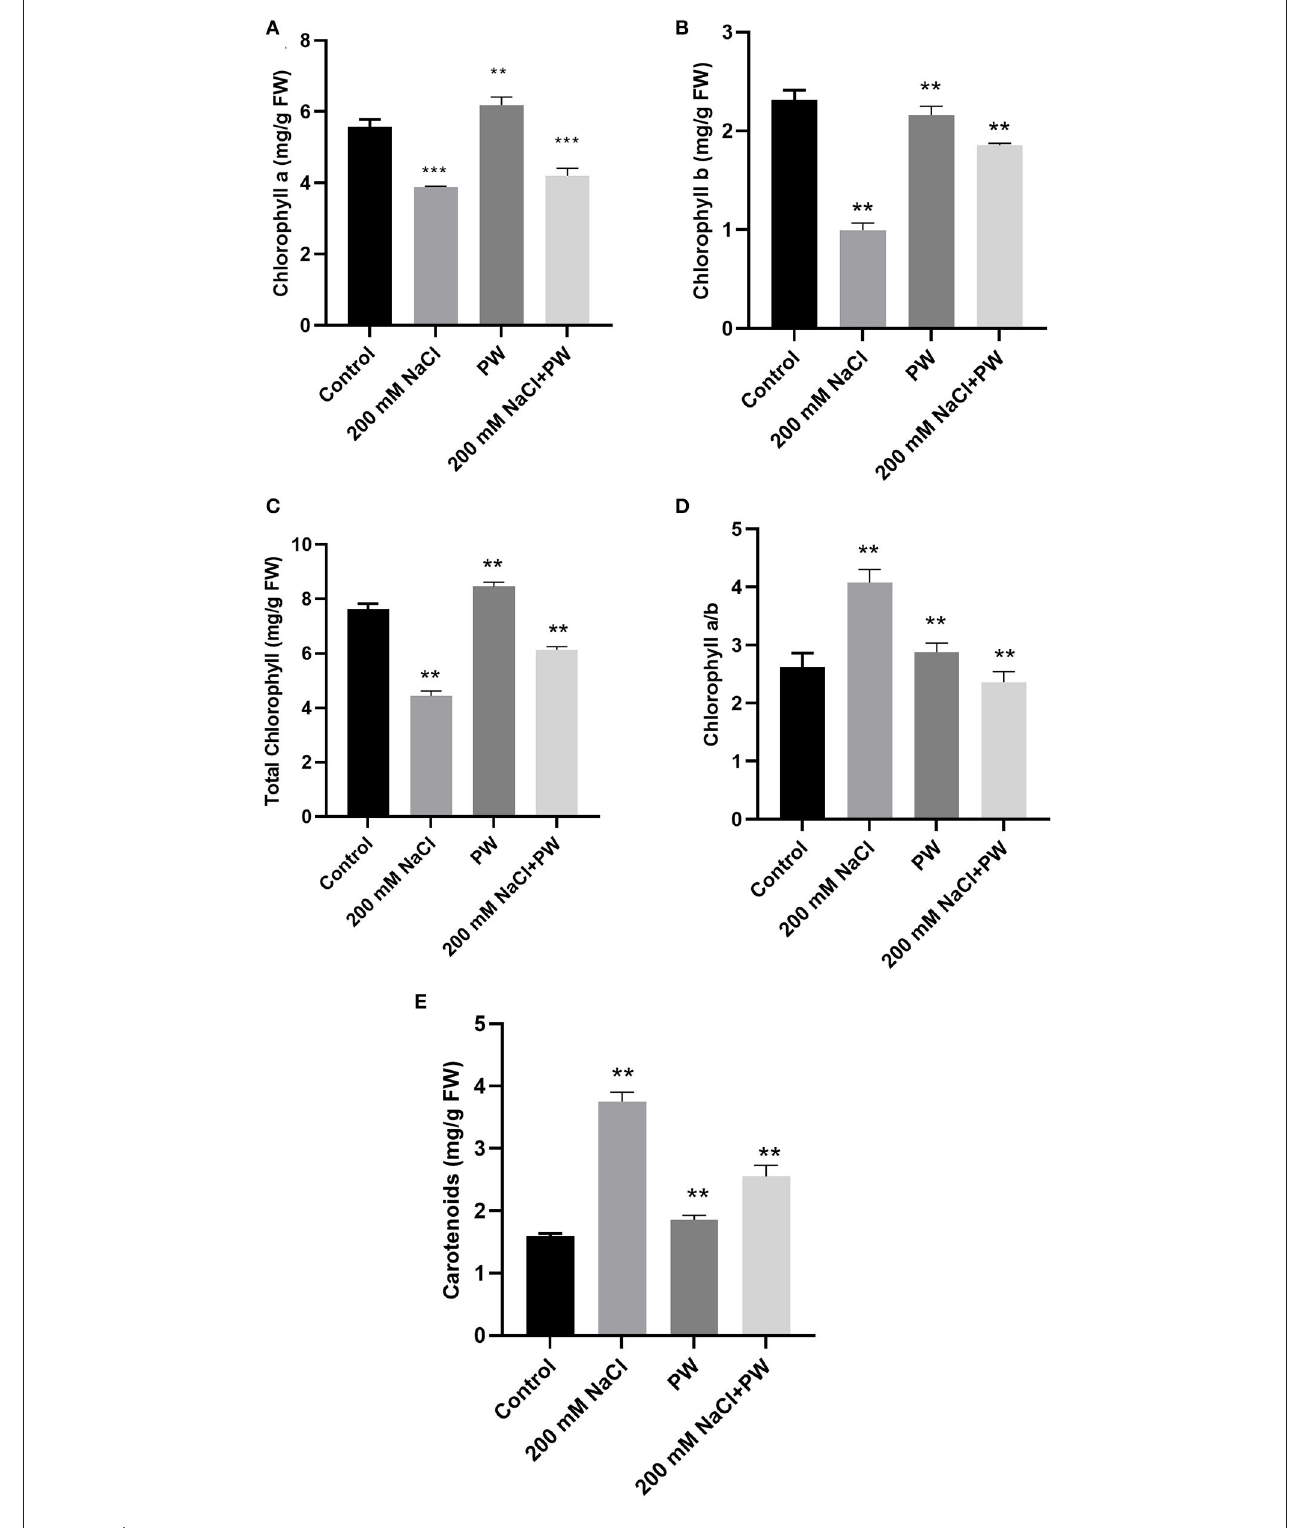
FIGURE 3 | Treatment of maize with S. lycopersici (PW) under normal and salt stress conditions. (A) Chlorophyll a, (B) chlorophyll b, (C) total chlorophyll, (D) chlorophyll a/b ratio, and (E) carotenoids. Bars indicate mean ± standard error from three replicates at a significant level of p ≤ 0.05. FW, fresh weight.